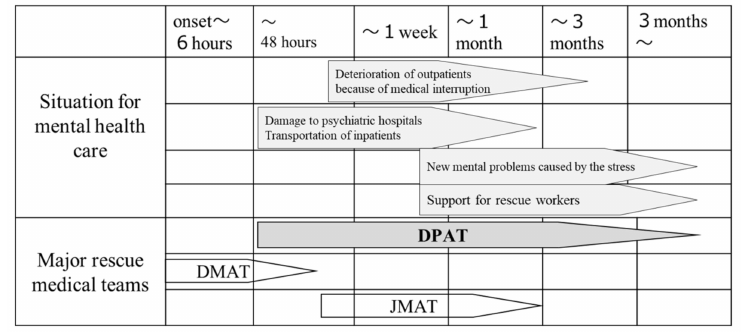
Figure 1. Postdisaster mental health care needs and DPAT dispatch periods. JMAT: Japan medical association team, DMAT; Disaster medical assistance team, DPAT; Disaster psychiatric assistance team.